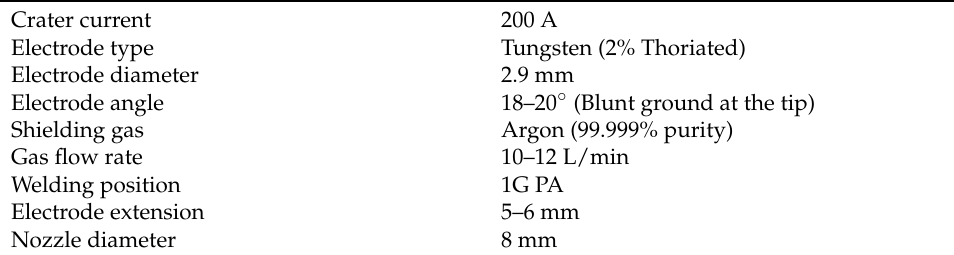
Table 2. Fixed parameters for bead-on-plate trials [39].